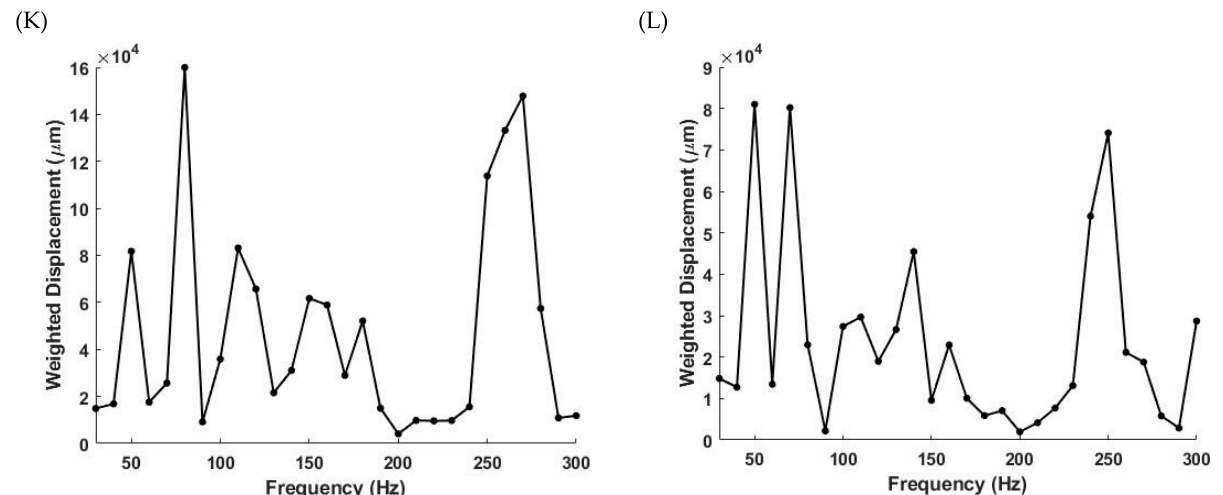
Figure 3. Comparison of the color-coded OCT images ( A – D ), pixel intensity versus depth plots ( E – H ), and weighted displacement in µ m versus frequency plots in Hz ( I – L ) for the areas marked by the arrows for normal skin, AK, BCC and SCC obtained using VOCT. The arrows in ( A ) through ( D ) mark the locations at which the measurements were made on biopsies with the results presented in panels ( E ) through ( L ). Note the plateau marked with a horizontal line in ( F ) through ( H ) in the pixel intensity versus depth plots occurs at a depth of about 0.2 mm. This is approximately at the interface between the epidermis and the papillary dermis. In normal skin and AK there is no fibrous tissue peak at 260 Hz ( I , J ) while in the cancerous lesions (( K ), BCC and ( L ), SCC) note the large peak at 260 Hz suggesting that this peak is where stiff fibrous tissue is deposited. The 260 Hz peak is one of the markers that can be used to differentiate between benign and cancerous skin lesions. Table 1. Statistical analysis for p -values for VOCT measurement for weighted displacement peak heights in micrometers for audible sound frequency of 80 Hz